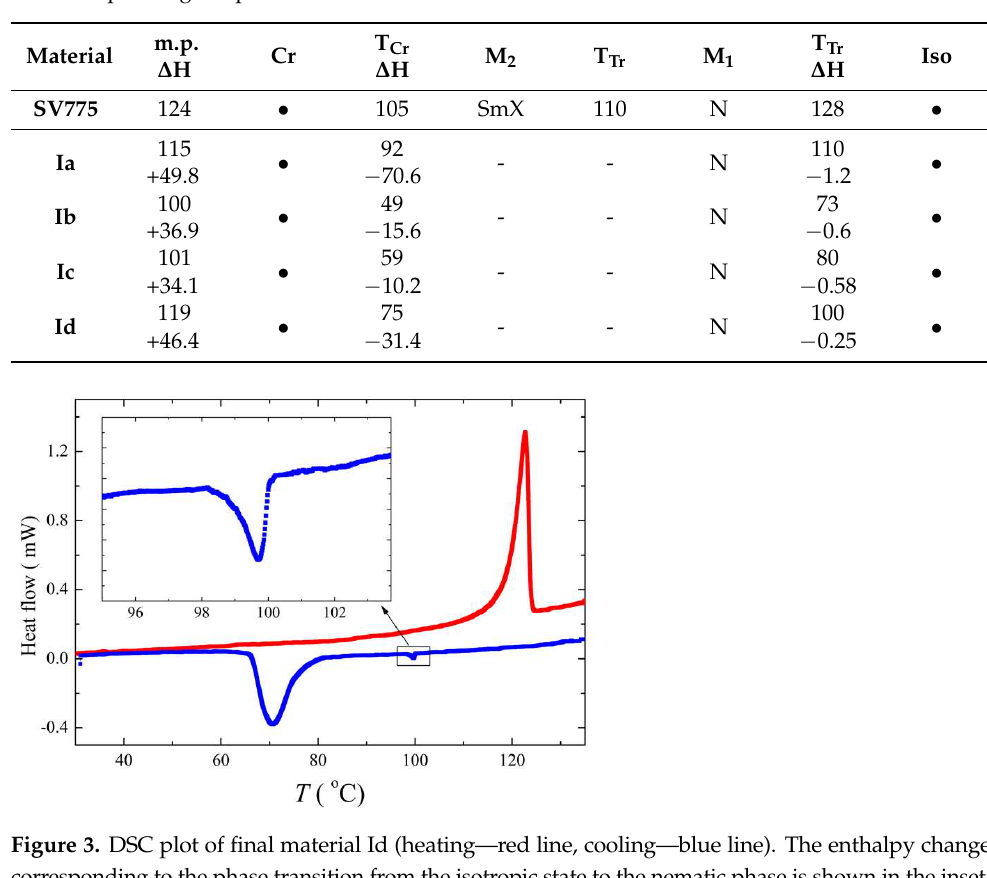
Table 1. Phase transition temperatures ( ◦ C) measured on cooling (5 ◦ C min − 1 ) and melting points,